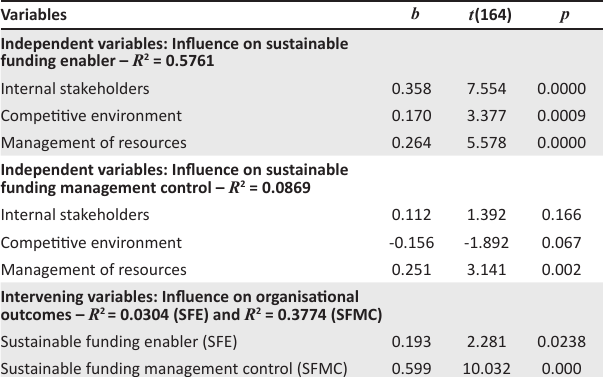
TABLE 3: Influence of the independent on the intervening variables, and influence of the intervening variables on the dependent variable.